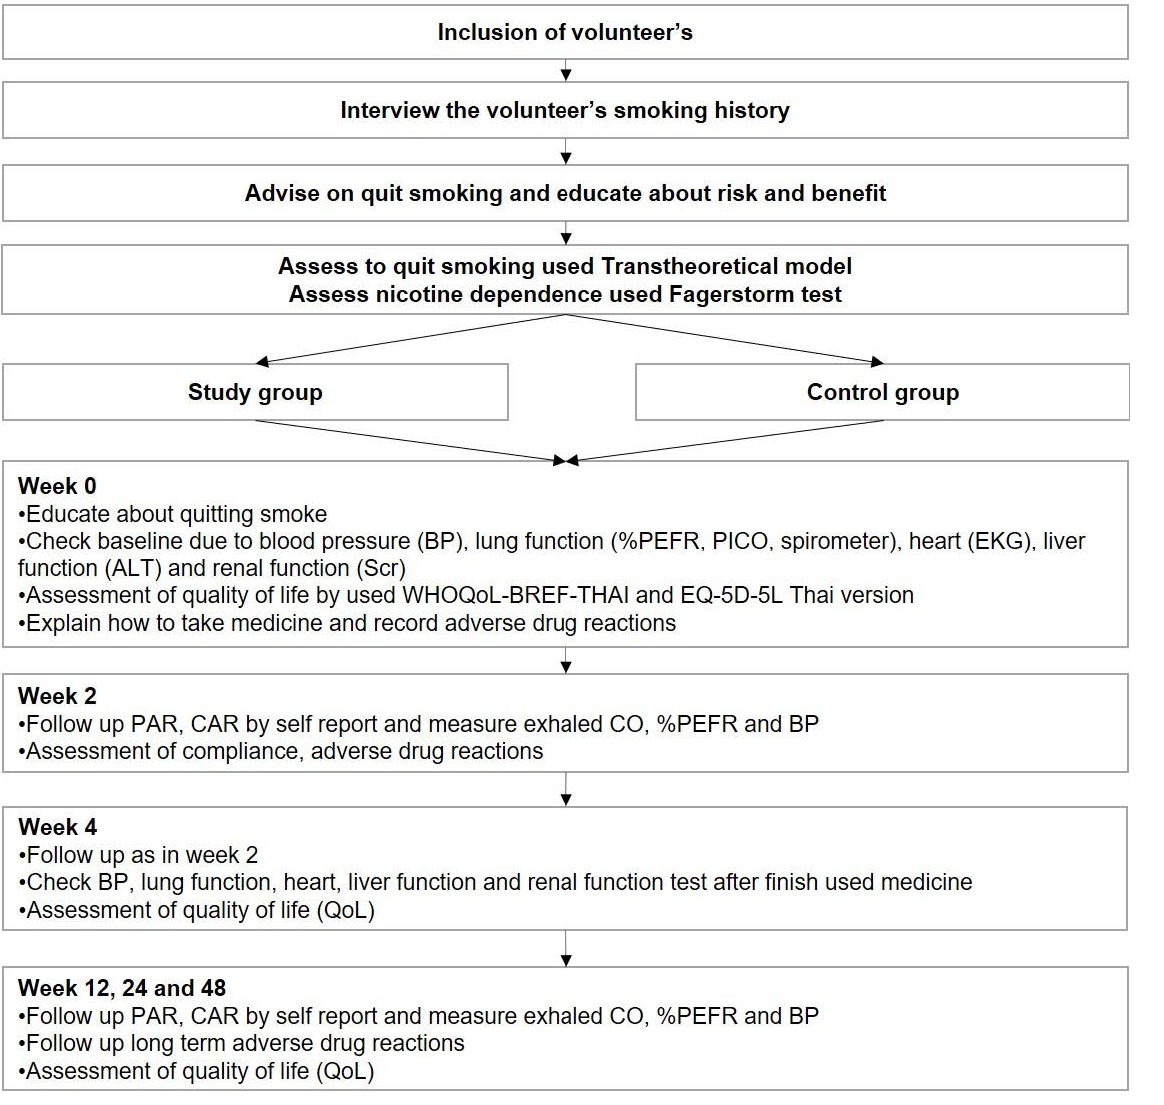
Figure 1. Participant inclusion and follow-up.